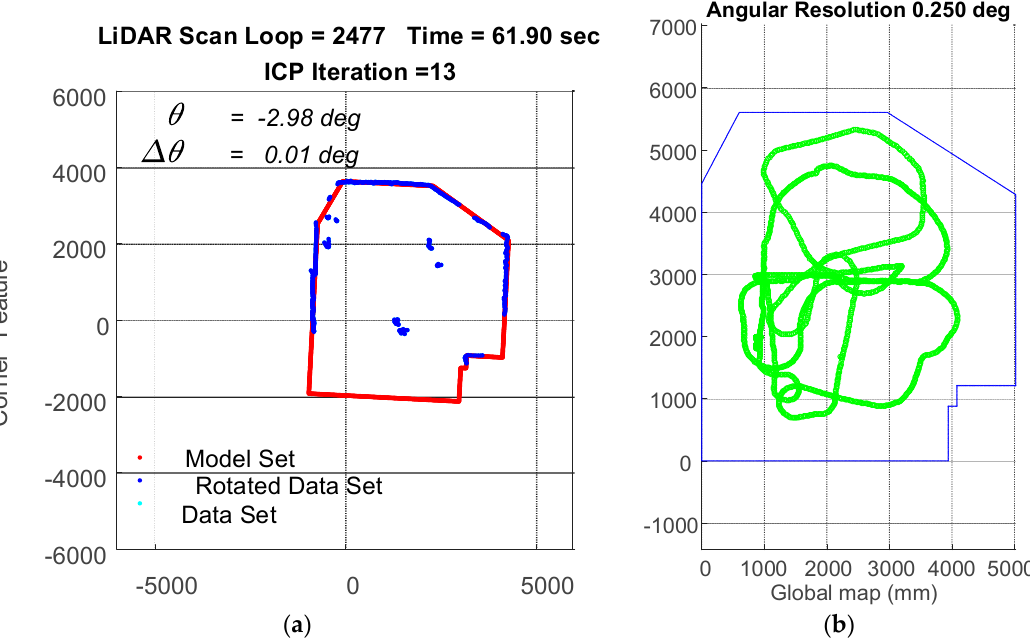
Figure 21. Localization result by using full-points ICP. ( a ) Point registration. ( b ) Robot trajectories.